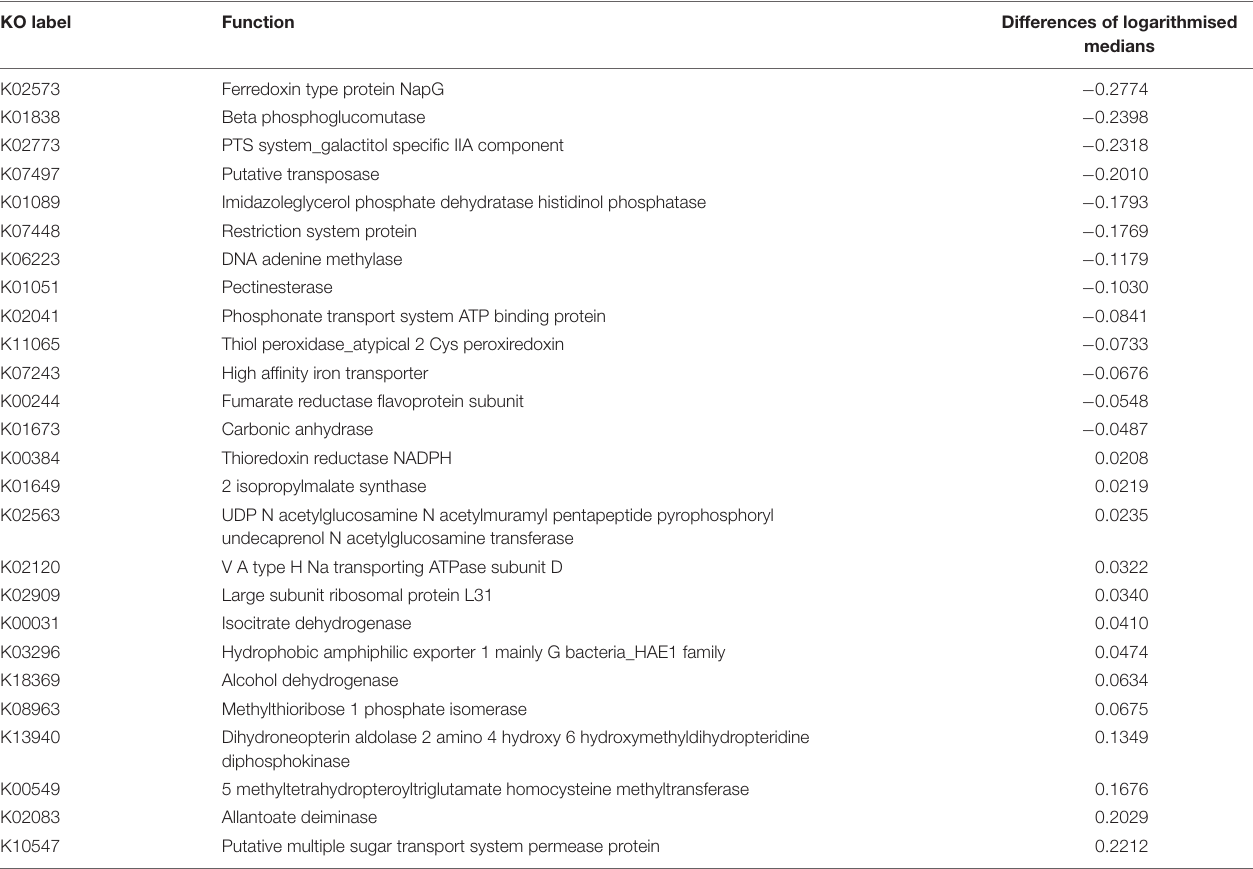
Negative values indicate higher levels in healthy controls; positive values indicate higher levels in Alzheimer’s disease (AD)